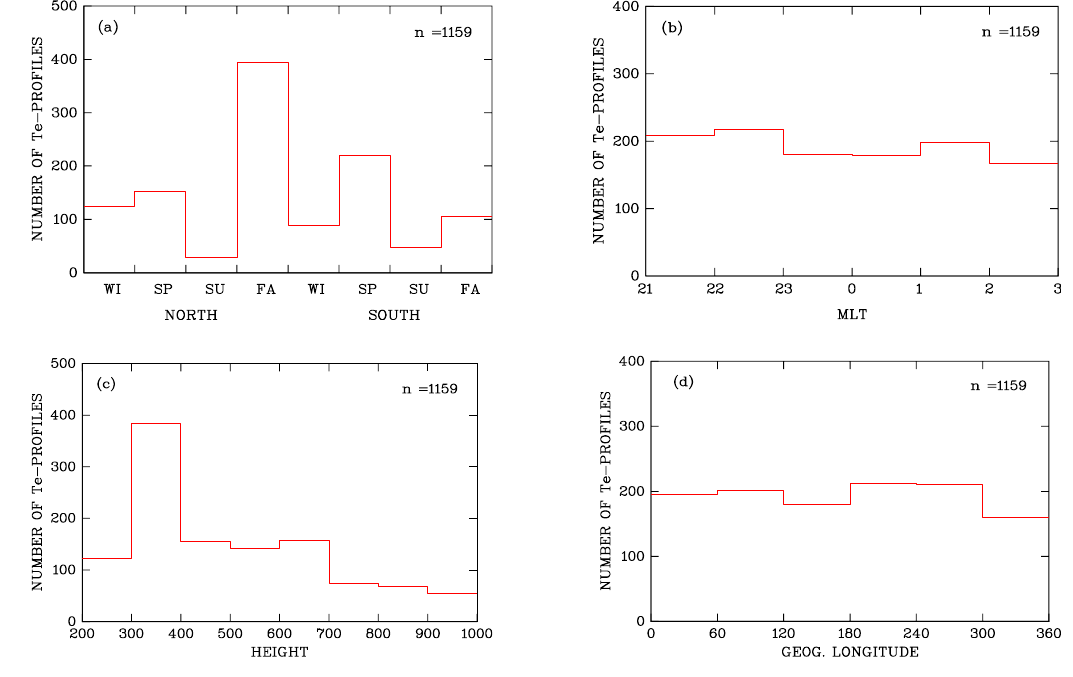
Fig. 3. Statistics of the data set analyzed in the present study. (a) Histogram indicating the hemispheric and seasonal distributions of 1159 parameterized electron temperature profiles. WI , SP , SU and FA stand for winter, spring, summer and fall, respectively. (b) Histogram indicating the magnetic local time ( MLT ) distribution of the data set. (c) Histogram describing the height distribution of the data set. (d) Histogram indicating the longitudinal distribution of the data